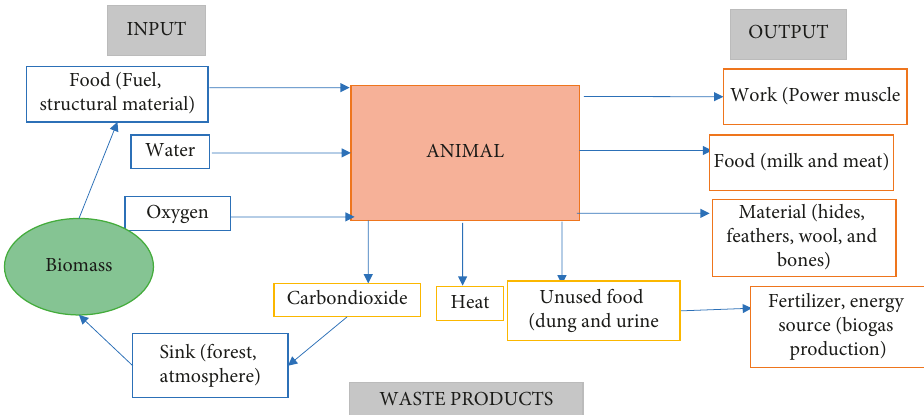
Figure 1: Input-output block for working animals, adapted from Fuller and Aye